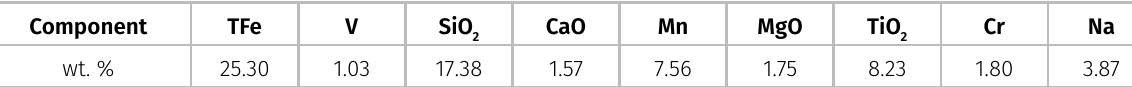
Table II. Chemical compositions of vanadium residue (wt. %).